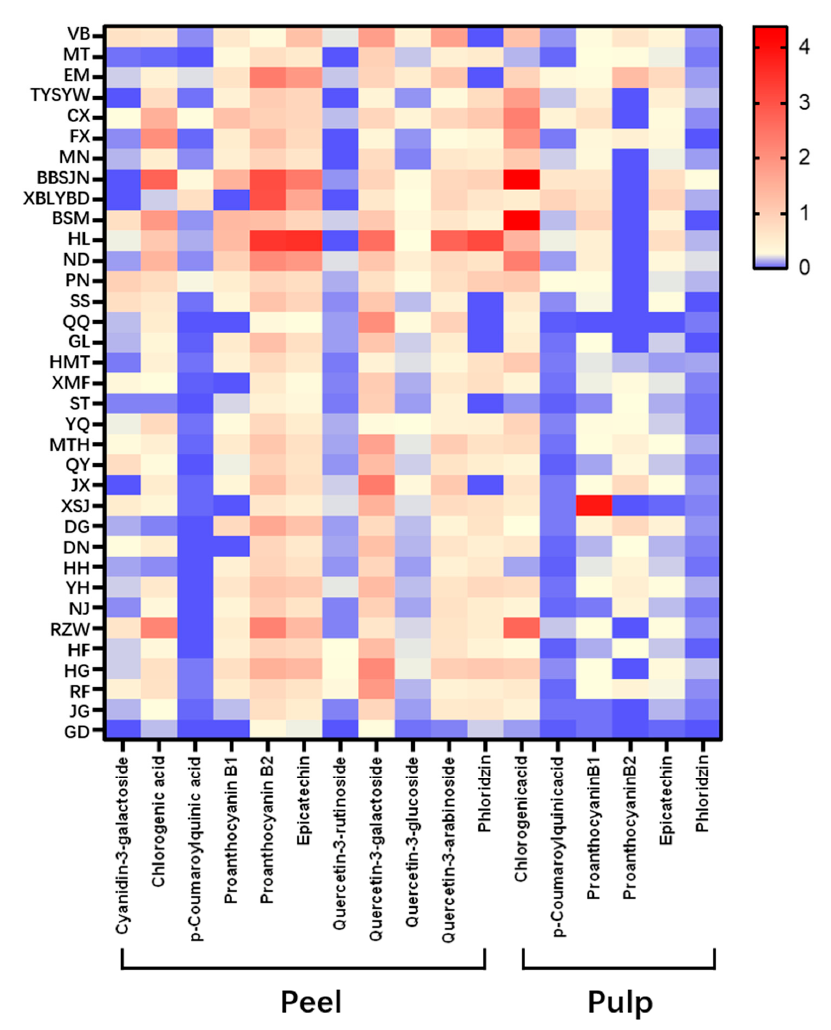
Figure 2. Contents of phenolic compounds in the peel and the pulp of 35 apple cultivars (mg/gdry weight of extracts (DW).